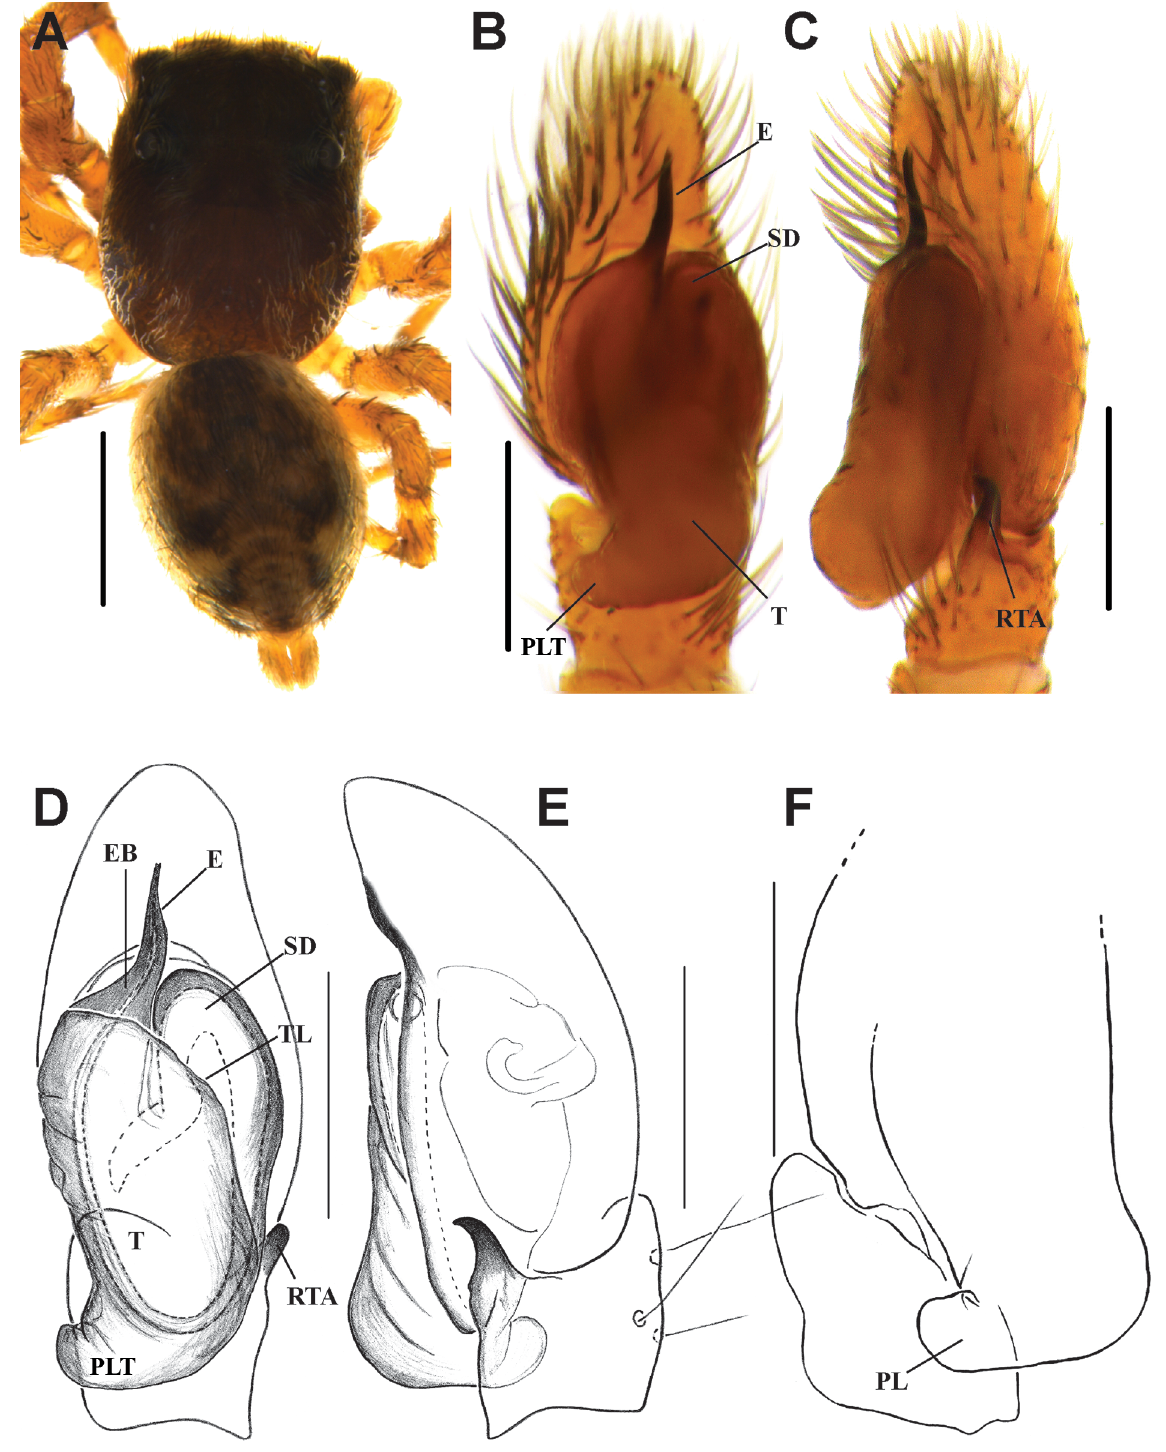
Fig. 9. Habrocestum ohiyaensis sp. nov. A . ♂, habitus, dorsal view. B . Palp, ventral view. C . Palp, retrolateral view. D . Palp, ventral view. E . Palp, retrolateral view. F . Palp, prolateral view. Abbreviations: E = embolus; EB = embolic base; SD = sperm duct; T = tegulum; TL = tegular ledge; PLT = proximal lobe of tegulum; RTA = retrolateral tibial apophysis. Scale bars: A = 1 mm; B–F = 0.2